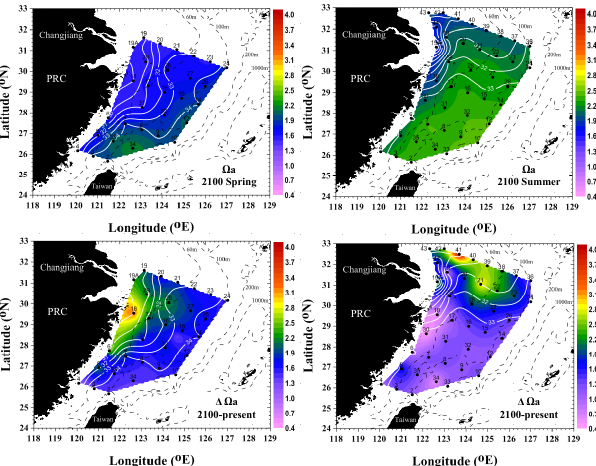
Fig. 8. (a) and (b) show predicted surface water (cid:127) a on the East China Sea shelf in spring and summer by the year 2100, respec- tively. (c) and (d) show the difference of (cid:127) a between the predicted (cid:127) a in 2100 and its present value ( 1(cid:127) a ) in spring and summer, re- spectively. Superimposed white lines are